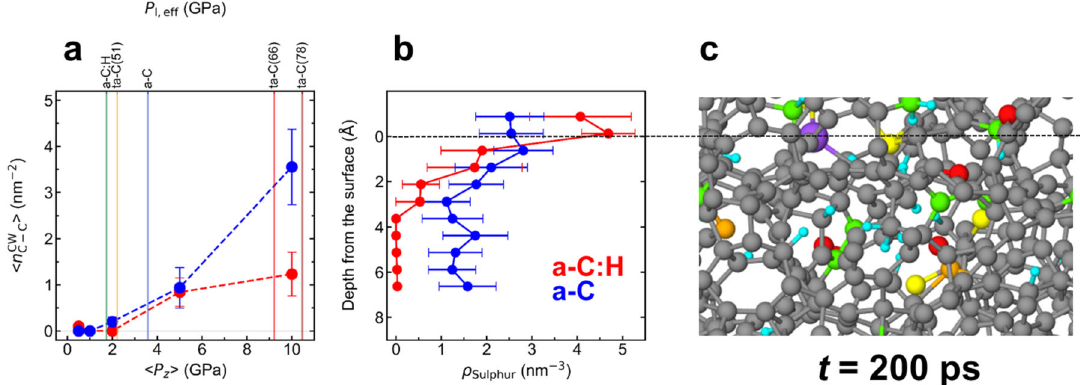
(cid:3) (cid:4) at t = 0.2 ns. The error C (cid:3) C